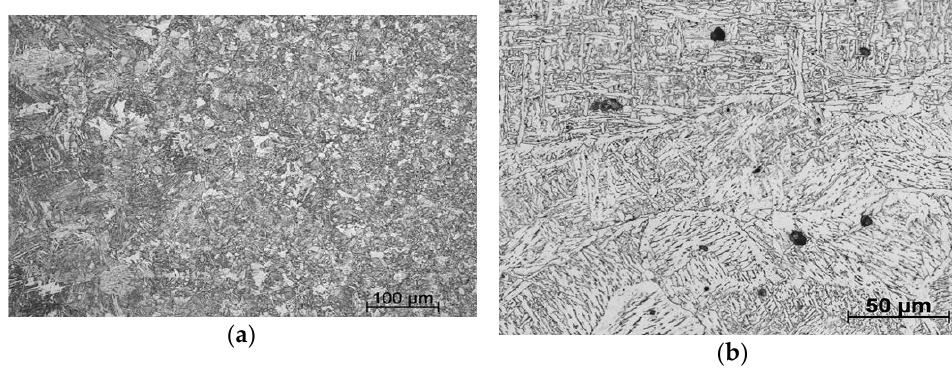
Figure 3. Microstructure in ( a ) the heat-affected zone and ( b ) the weld metal. The WM microstructure was oriented preferentially in the direction of the solidification gradient and consisted of acicular ferrite and grain boundary ferrite (see Figure